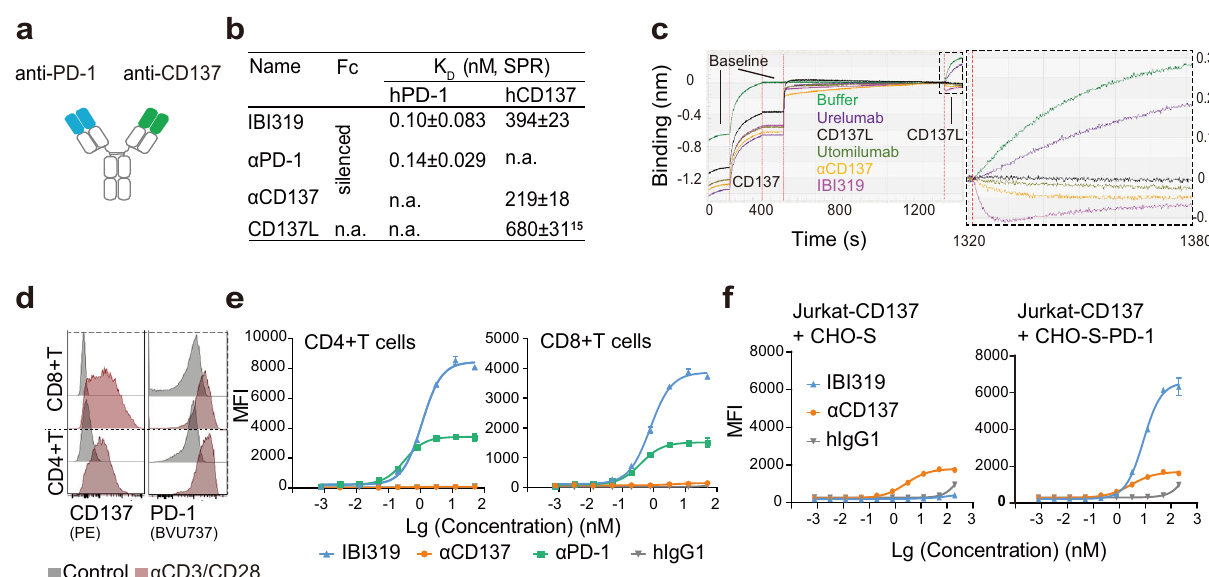
Fig. 1 IBI319 activates CD137 in a PD-1 dependent manner. a Structure diagram of IBI319 on a human IgG1 backbone. IBI319 consists of a Fab region binding to PD-1 and CD137 and an Fc fragment with null effector function. b The dissociation constants (K D s) of IBI319, α PD-1, and α CD137 for human PD-1 and human CD137, respectively, determined via SPR (3 independent experiments; mean ± standard deviation (SD); n.a. not analysed). c CD137 ligand- blocking properties of IBI319, α CD137, in-house-generated urelumab and utomilumab via BLI. d PD-1 and CD137 expression on CD4 + and CD8 + T cells from a representative healthy donor before (black) and after activation by anti-CD3/CD28 antibody-coated beads (red) measured by fl ow cytometry (FACS). e Binding af fi nities of IBI319 and control antibodies for activated CD4 + T cells and CD8 + T cells measured by FACS. f Binding af fi nities of IBI319 and control antibodies for Jurkat-CD137 cells co-cultured with CHO-S or CHO-S-PD-1 cells determined by FACS and calculated from the CTV + CFSE + population. e , f two technical replicates of one representative experiment from three independent experiments; mean and